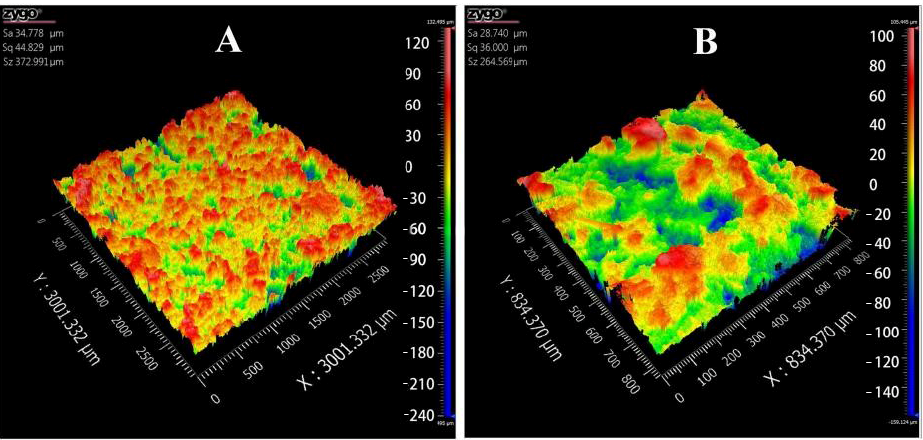
Figure 7. Three-dimensional (3D) topography images of 3D-printed compound dispersive tablets. ( A ): 2.75×; ( B ): 10×. Table 1. Surface roughness parameters of 3D-printed compound dispersible tablets.